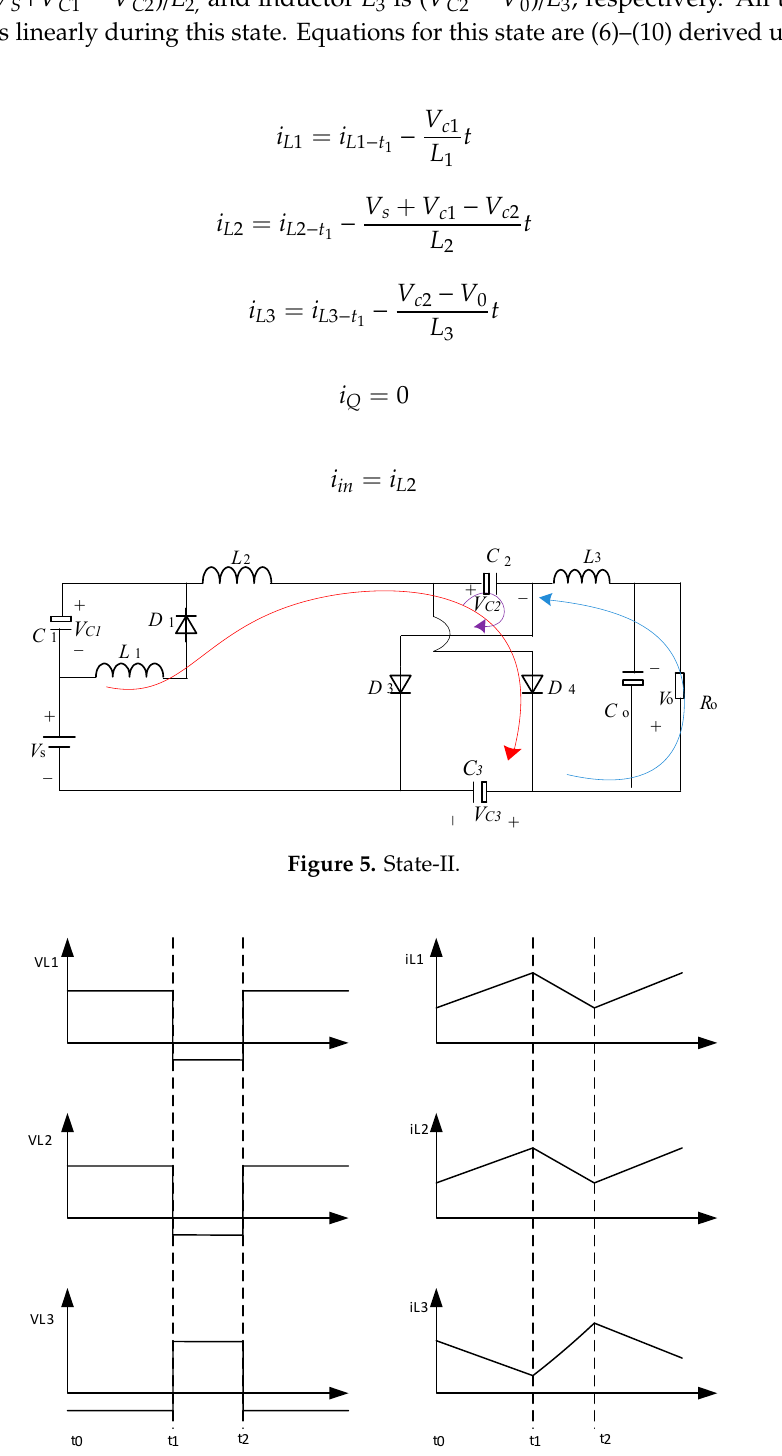
Figure 6. Steady-state behavior.